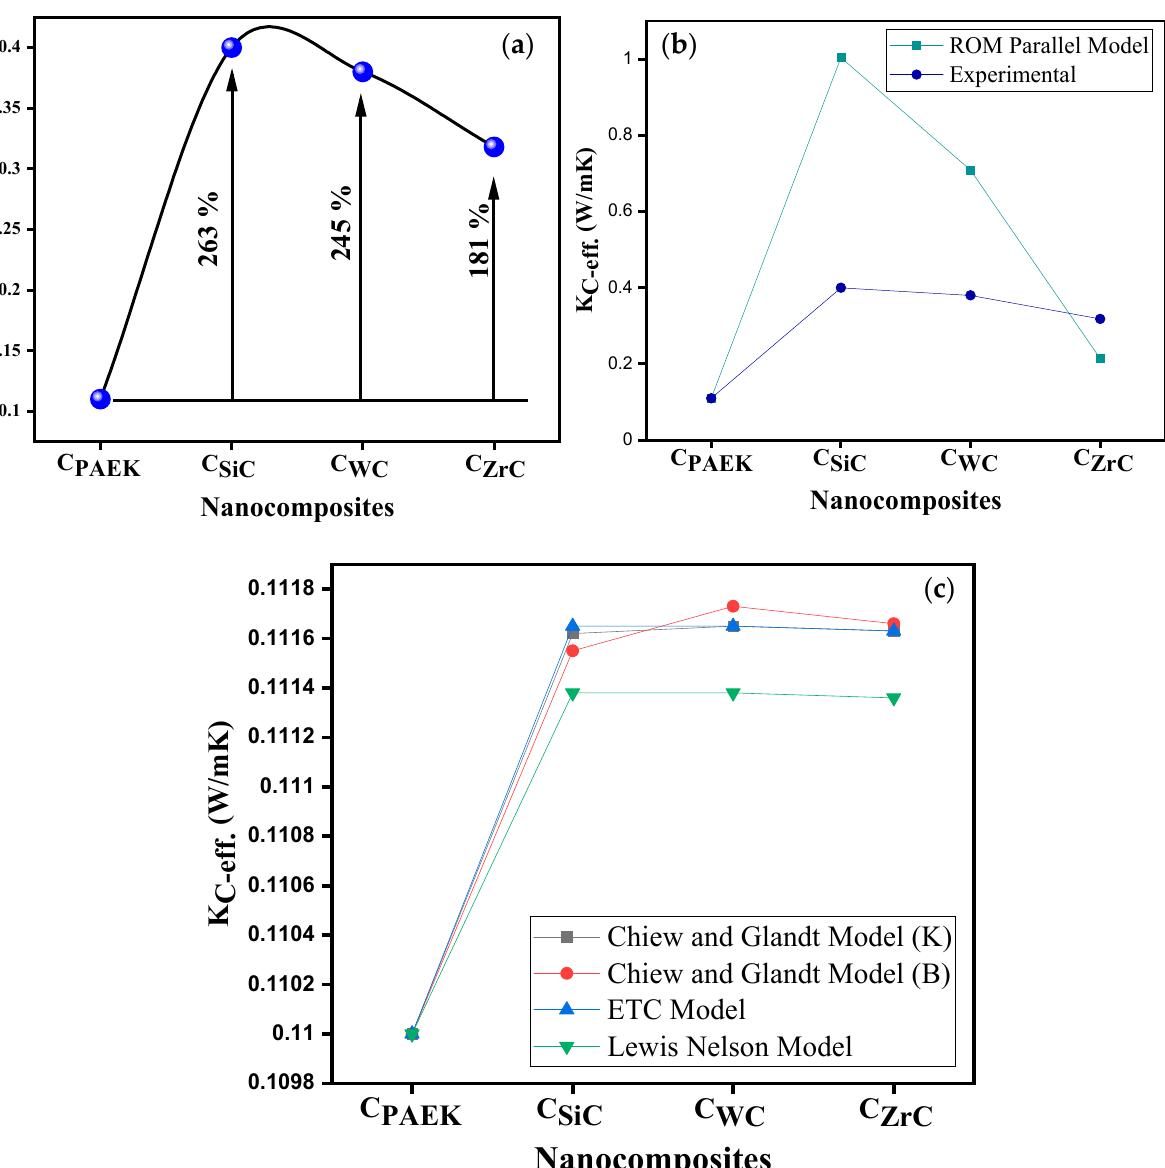
Figure 7. ( a )Thermal conductivity (TC) of NCs; ( b ) theoretical models employed to predict the trend in TC and the rule of the mixture parallel model; and ( c ) Chiew and Glandt, ETC, and Lewis Nelson models.